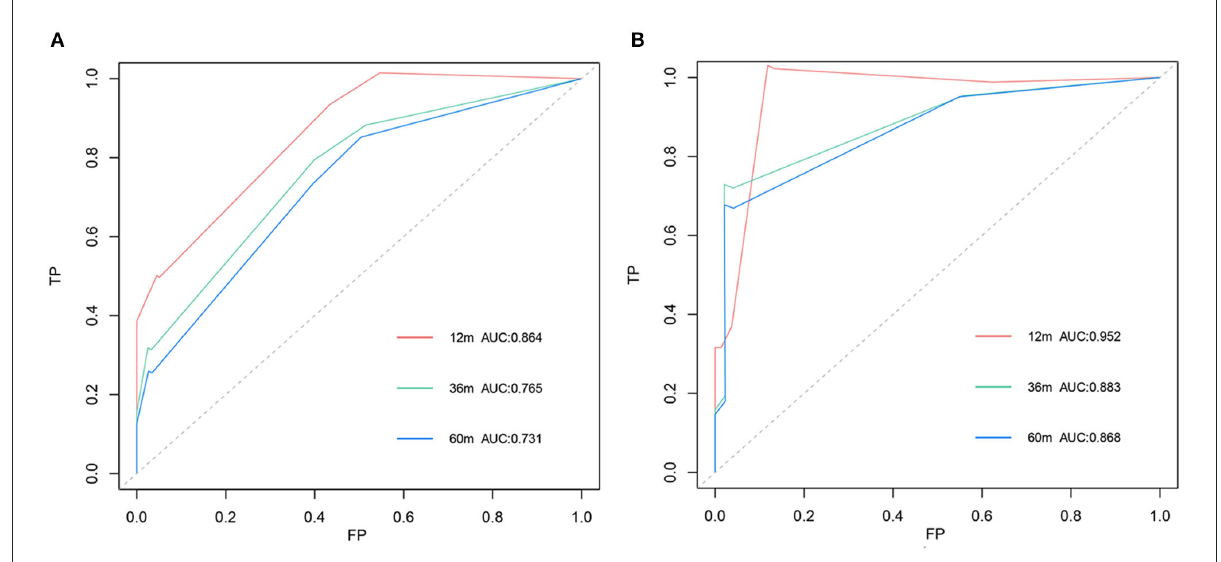
FIGURE3 Time–dependent ROC in the training set (A) and in the validation set (B) .